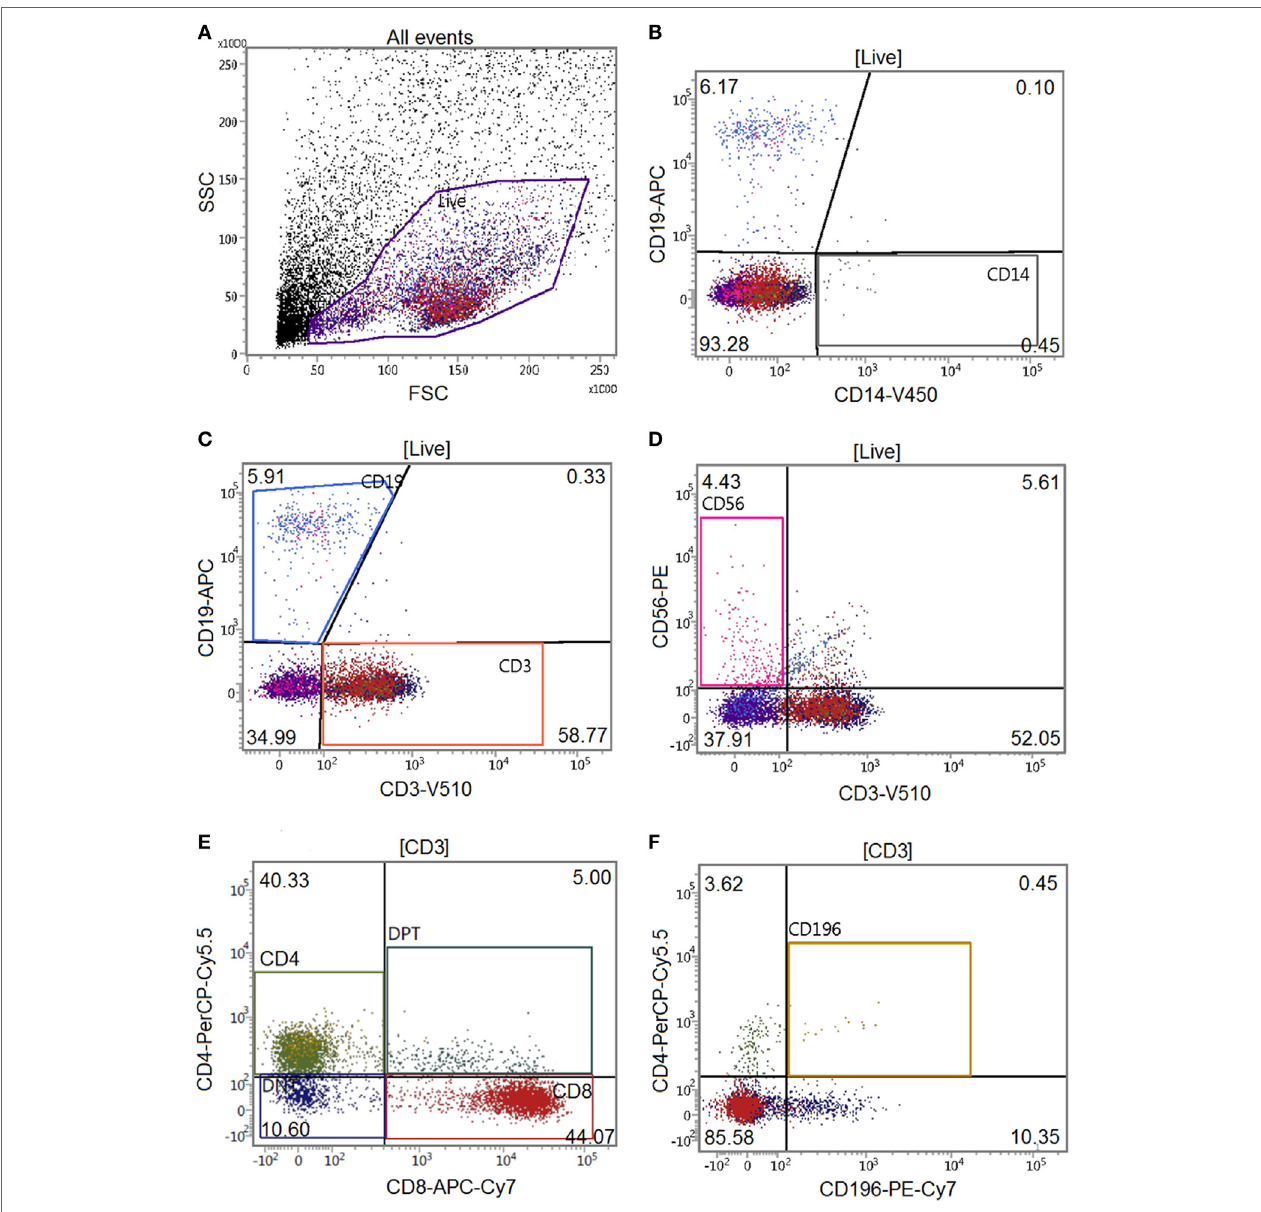
FigUre 1 | Gating tree of flow cytometry experiments. The antibody combination for flow cytometric experiments was CD14-V450/CD19-APC/CD3-V500/ CD56-PE/CD4-PerCPCy5.5/CD8-APC-Cy7/CD196-PE-Cy7 ( Table 1 ). Acquisition and analysis were performed on a BD FACSverse flow cytometer using associated FACSuite software. The number in quadrants indicate percentages of cells in the corresponding gating. The gating tree was set as follows: (a) forward scatter/sideward scatter represents the distribution of cells in the light scatter based on size and intracellular composition, respectively, where the live population is encircled in purple. In the “live” population, (B) CD14 + , (c) CD19 + , CD3 + , (D) CD56 + CD3 − cells were identified. In the CD3 + gating, (e) CD4 + , CD8 + , and (F) CD196 + populations were identified. Here, a characterization of a gingival fibroblast-peripheral blood mononuclear cell coculture after 21 days is